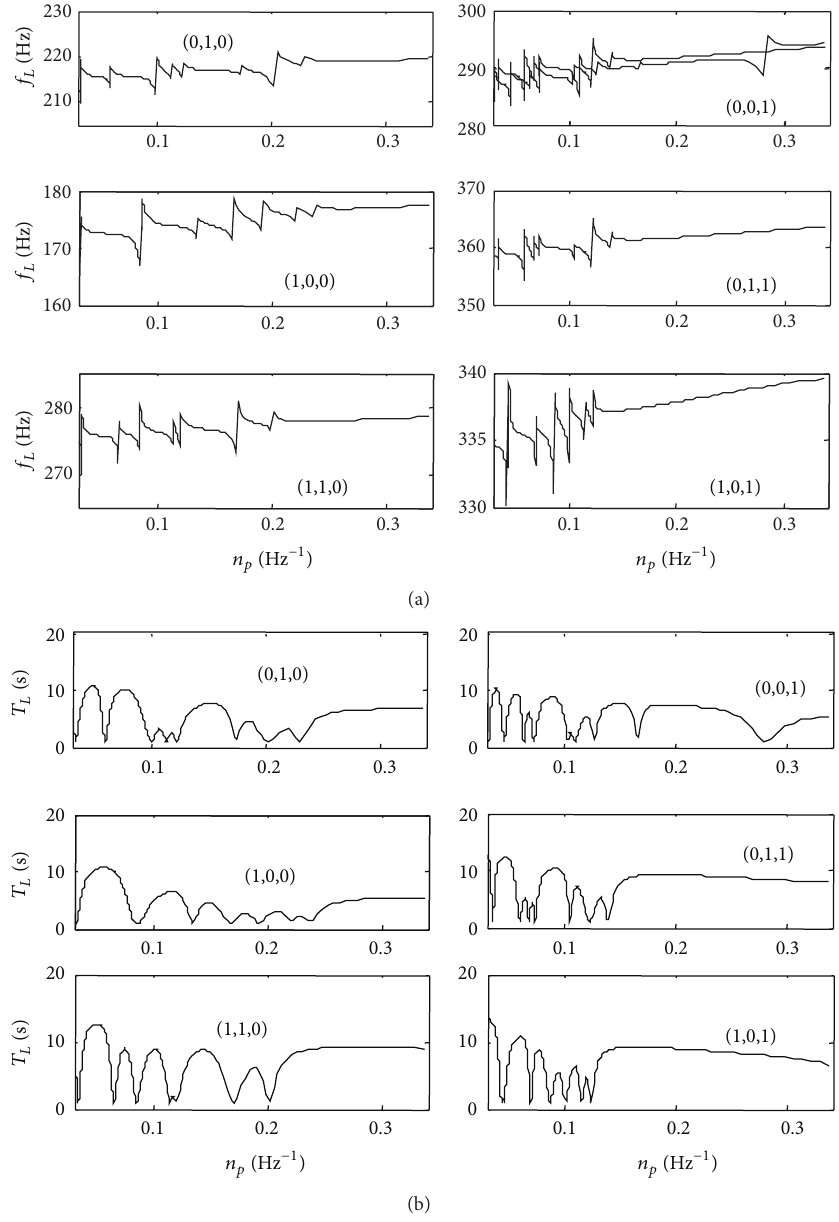
Figure 3: Resonance frequencies and decay times of the first few enclosure-controlled modes as a function of panel modal density: (a) resonance frequency, (b) decay time. 𝐿 𝑍 = 0.6 m, 𝑇 𝑎𝑁 = 15 s, 𝑇 𝑝𝑀 = 0.5